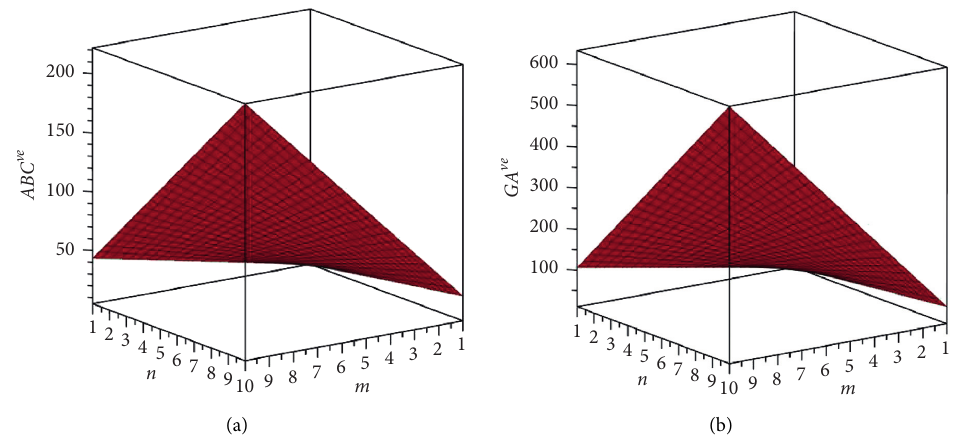
( VC [ m, n ]) (b) M β ve 1